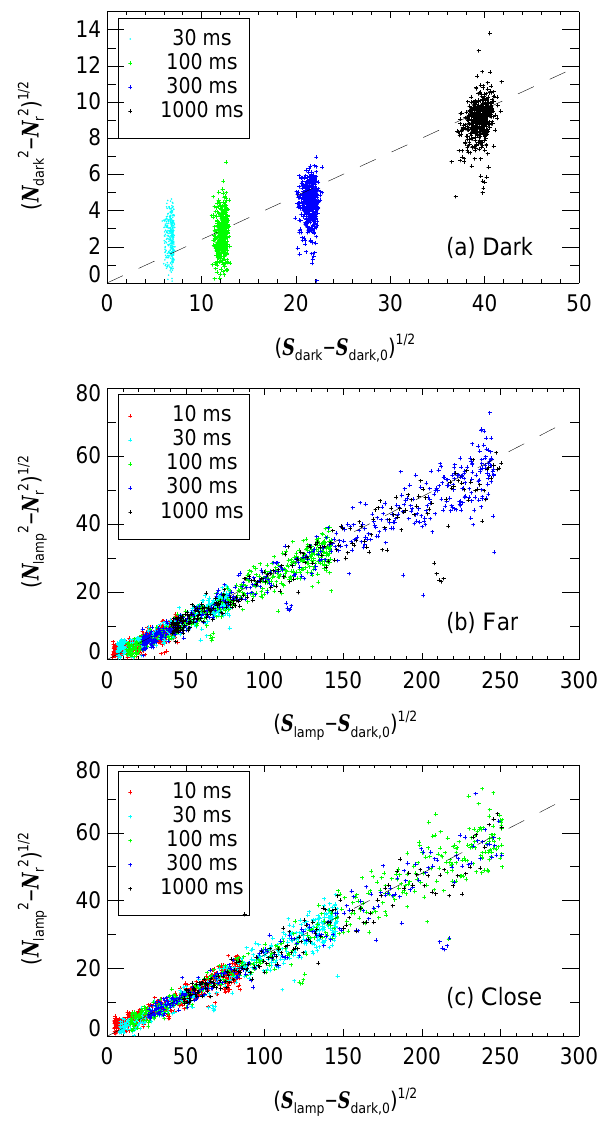
Figure 4. Increase of noise ( N ) with the square root of CCD sig- nals from dark measurements ( S dark ) and 1000W irradiance stan- dard measurements ( S lamp ) of instrument 62001: (a) dark, (b) lamp distance 700mm (far), and (c) lamp distance 350mm (close). Noise was corrected for residual noise ( N r ≈ 7) at zero integration time, and signals were corrected for constant electronic offsets ( S dark , 0 ≈ 900). For the dark measurements at integration times ≤ 30ms, the noise increase is too small to be determined correctly. The dashed lines indicate an approximate linear